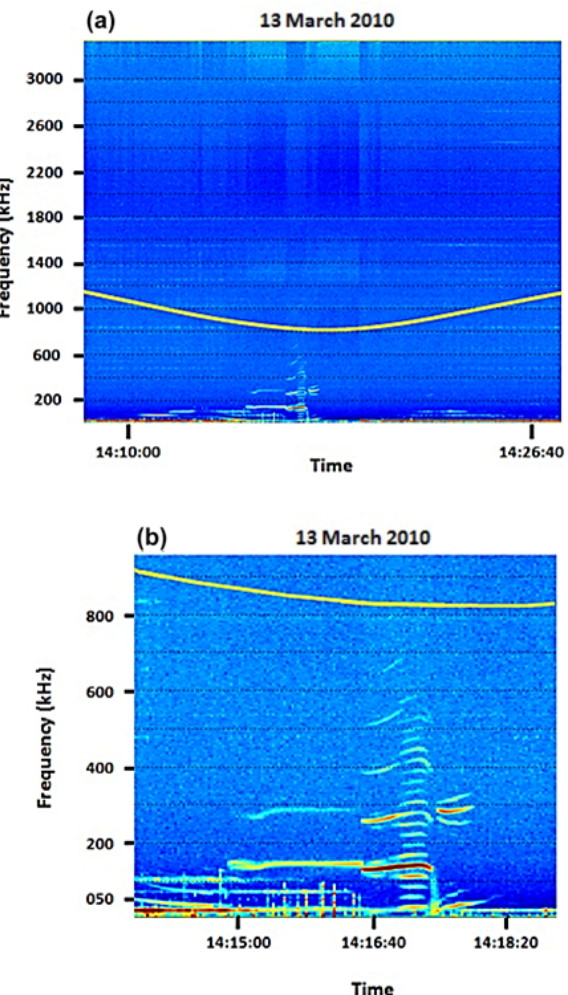
Figure 1. Example of frequency-banded wave emission recorded by the ICE experiment on board DEMETER on 21 February 2010. Panel (a) displays an overview of the dynamic spectrum in the fre- quency range from a few kilohertz to 3.5MHz. Panel (b) shows a zoomed-in part for the event in the frequency bandwidth between a few kilohertz and 1100kHz. The gyro-frequency is indicated by the yellow curve.